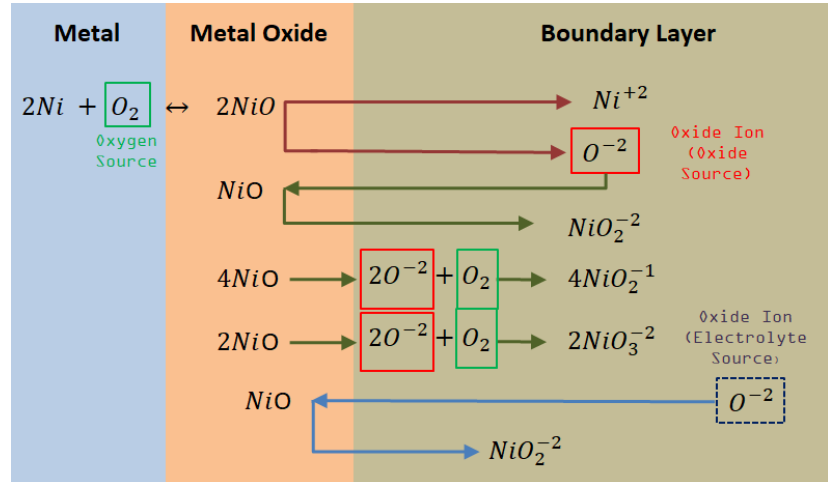
Figure 5. Corrosion mechanisms of Ni in contact with Oxyanionic Salts.